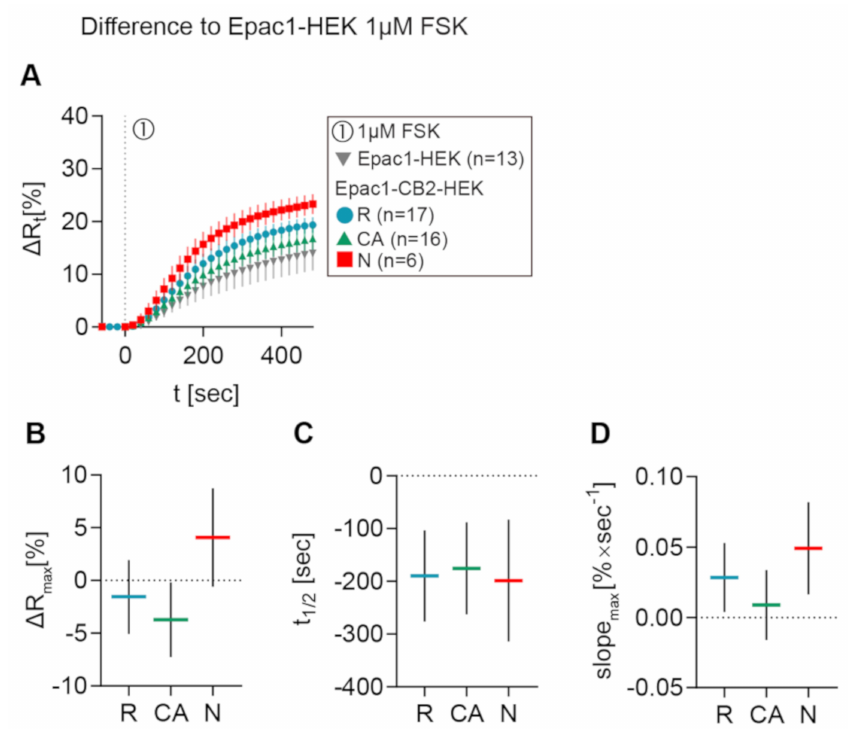
Figure 5. Di ff erences in FRET response parameters after FSK stimulation between